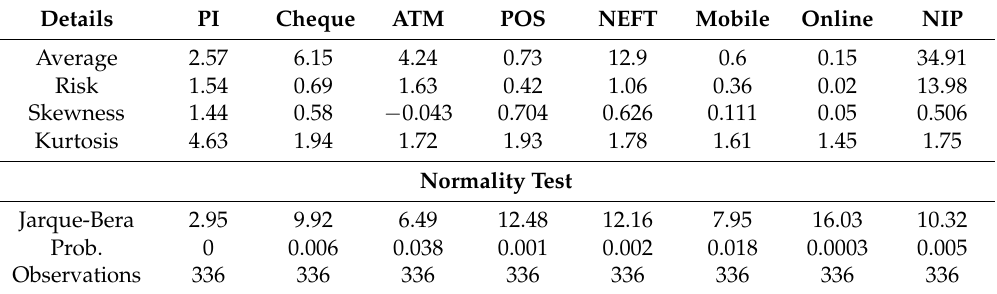
Table 4. Descriptive